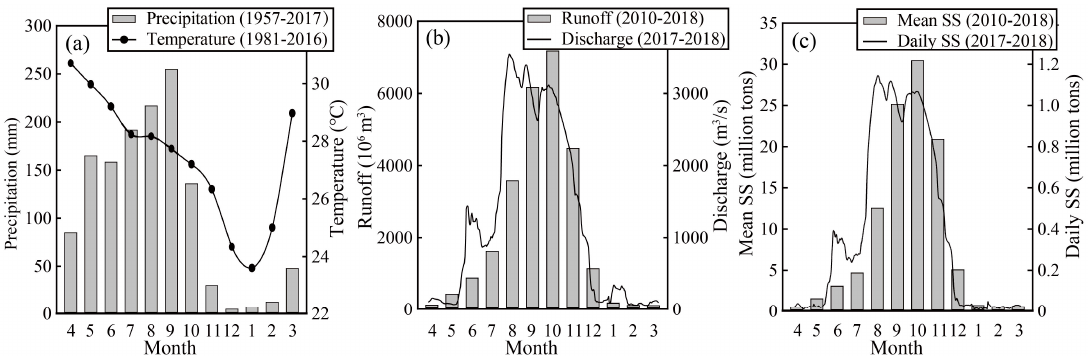
t (Figure 2a,b) (Royal Irrigation Department Thailand, http://hydro-4.rid.go.th).